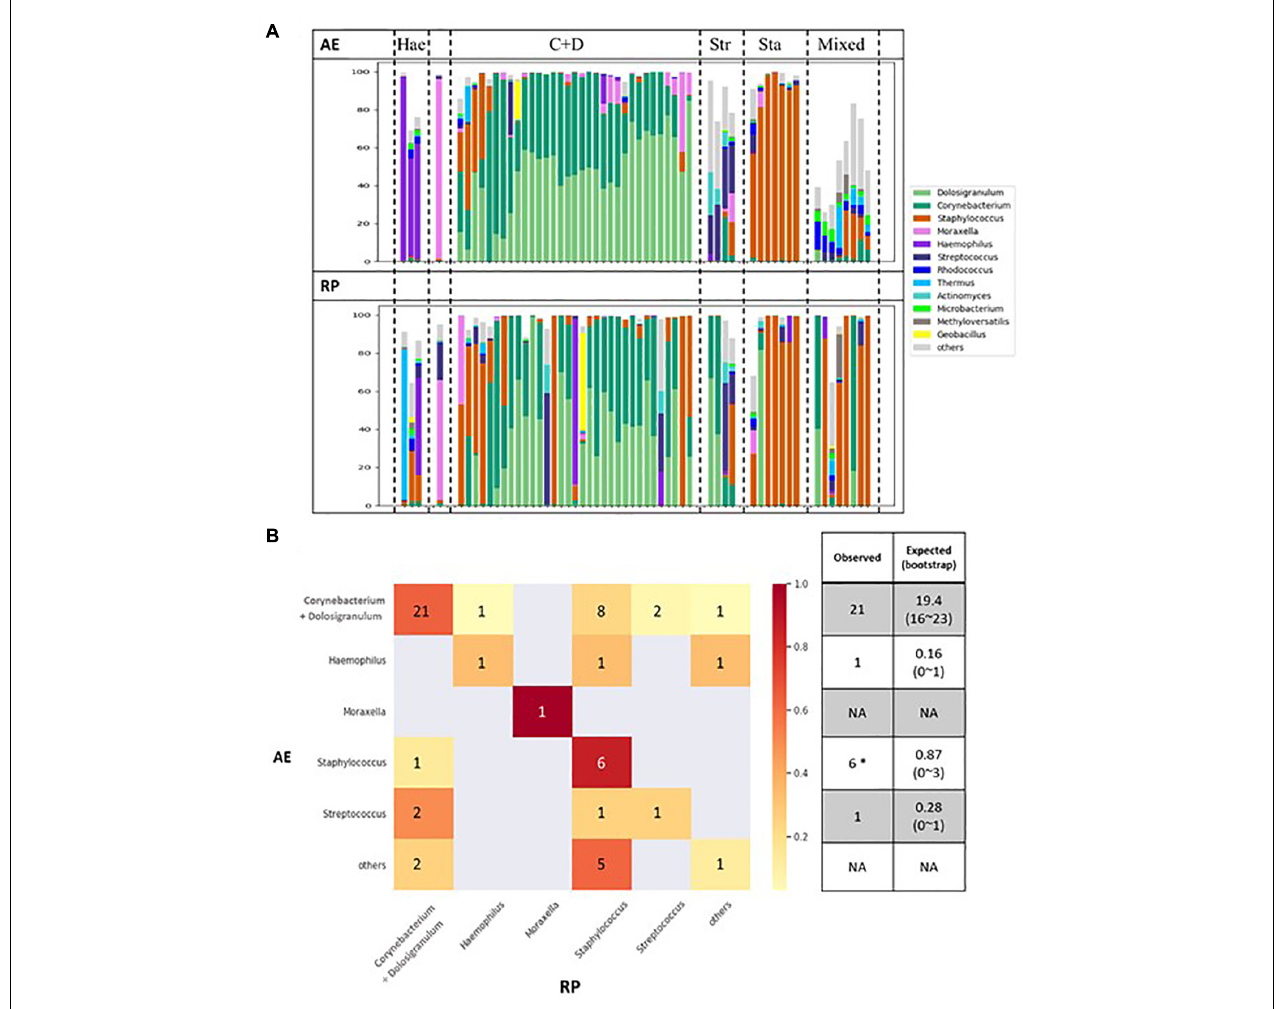
FIGURE 3 | (A) Changes of microbial compositions in nasal samples moving from AE (top) into RP (bottom). (B) Transitions between microbial clusters from AE into RP. Expected number of self-transitions and the 95% interval are calculated assuming random transitions as described by Teo et al.